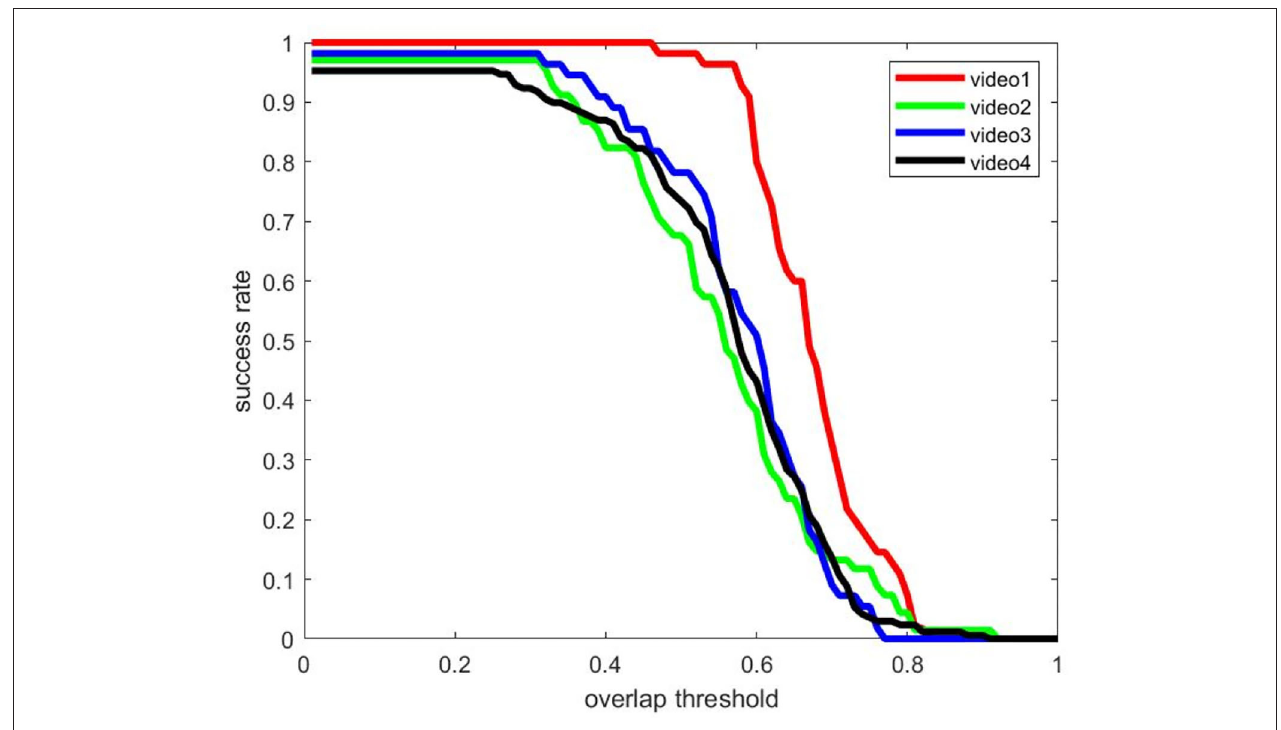
FIGURE 12 | The success rate of the test dataset.